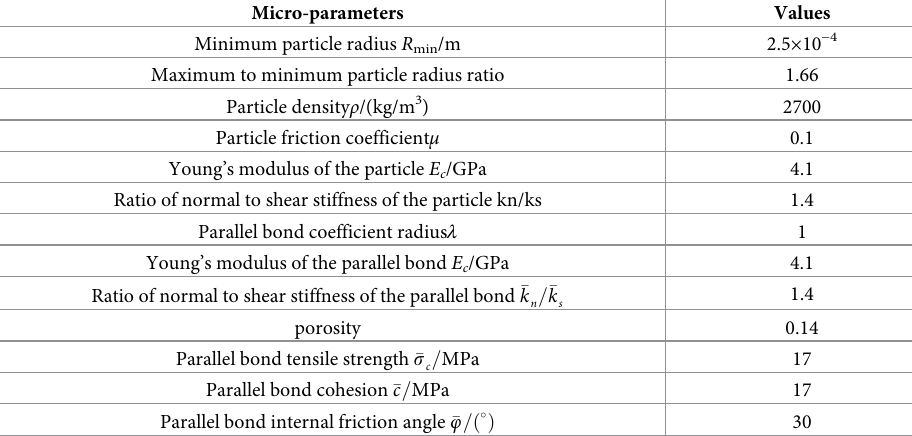
Table 2. Meso-mechanical parameters used in PFC2D